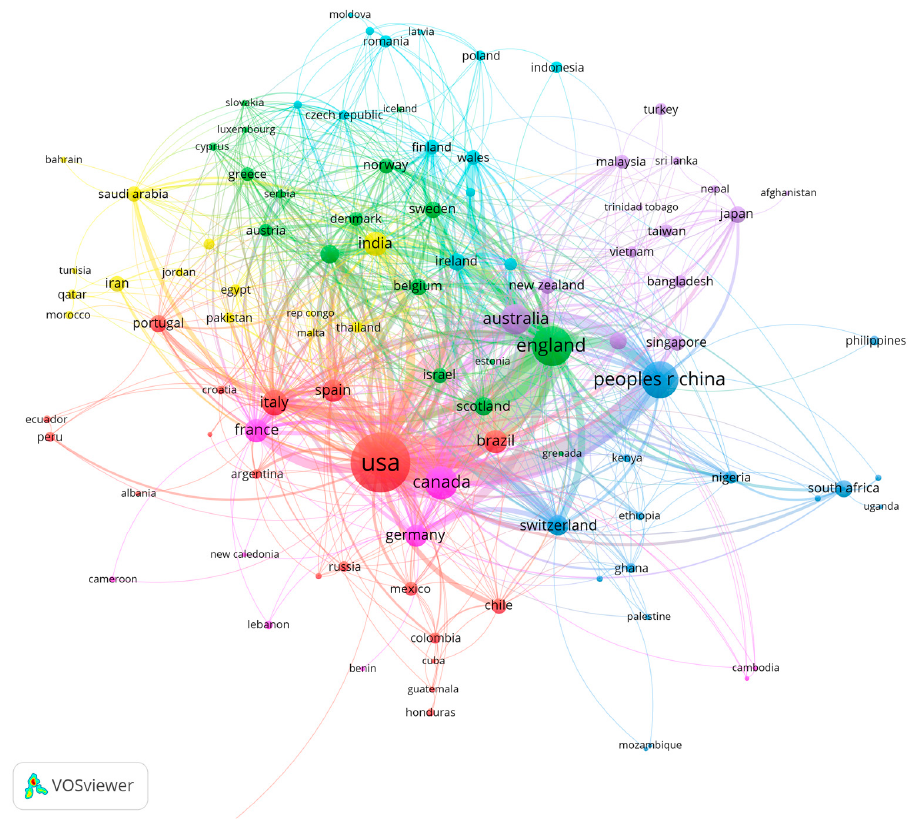
Figure 1. The co-authorship network of countries/regions.